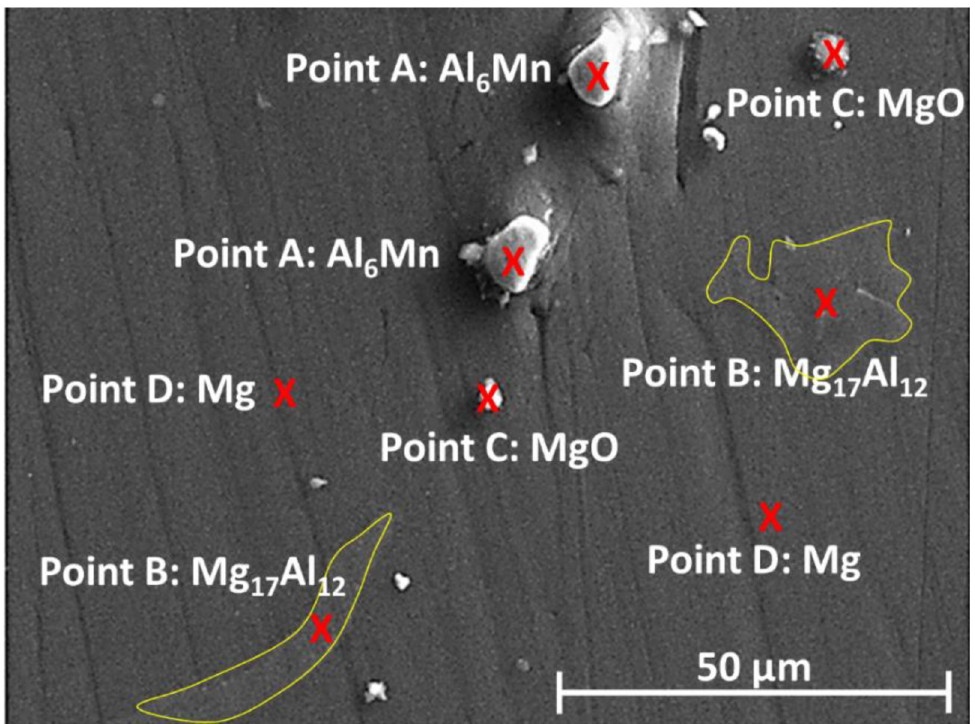
Fig 4. The SEM image of the AM60 magnesium alloy.